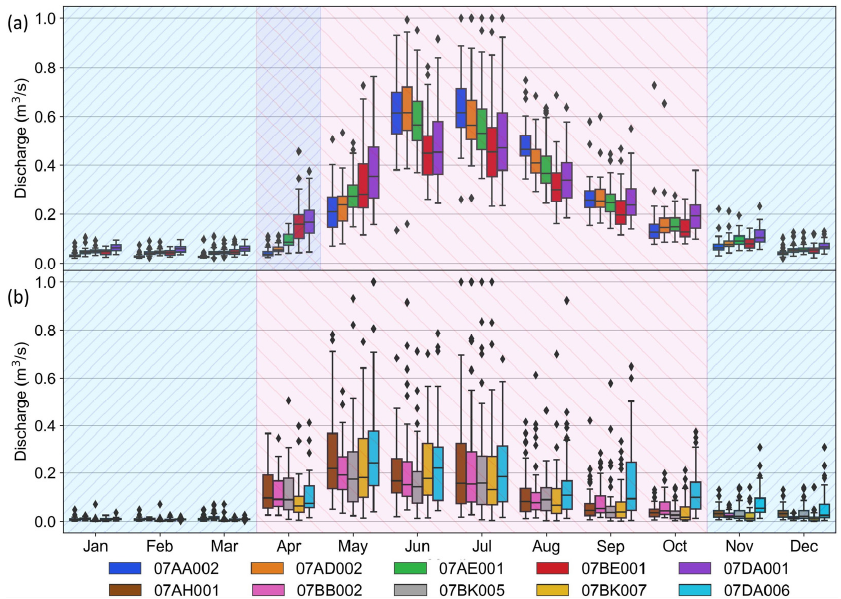
Figure 2. Averaged normalized monthly streamflow data distribution by train ( a ) and test ( b ) sets. Cold months are highlighted with blue color, and warm months are shaded by pink color. In part ( a ), for the month of April, blue and pink colors are overlapped as this month was considered a warm month for 07BE001 and 07DA001 but a cold month for 07AA002, 07AD002, and 07AE001. For part ( b ), January, February, March, November, and December are regarded as cold months, while April, May, June, July, August, September, and October are considered as warm months.